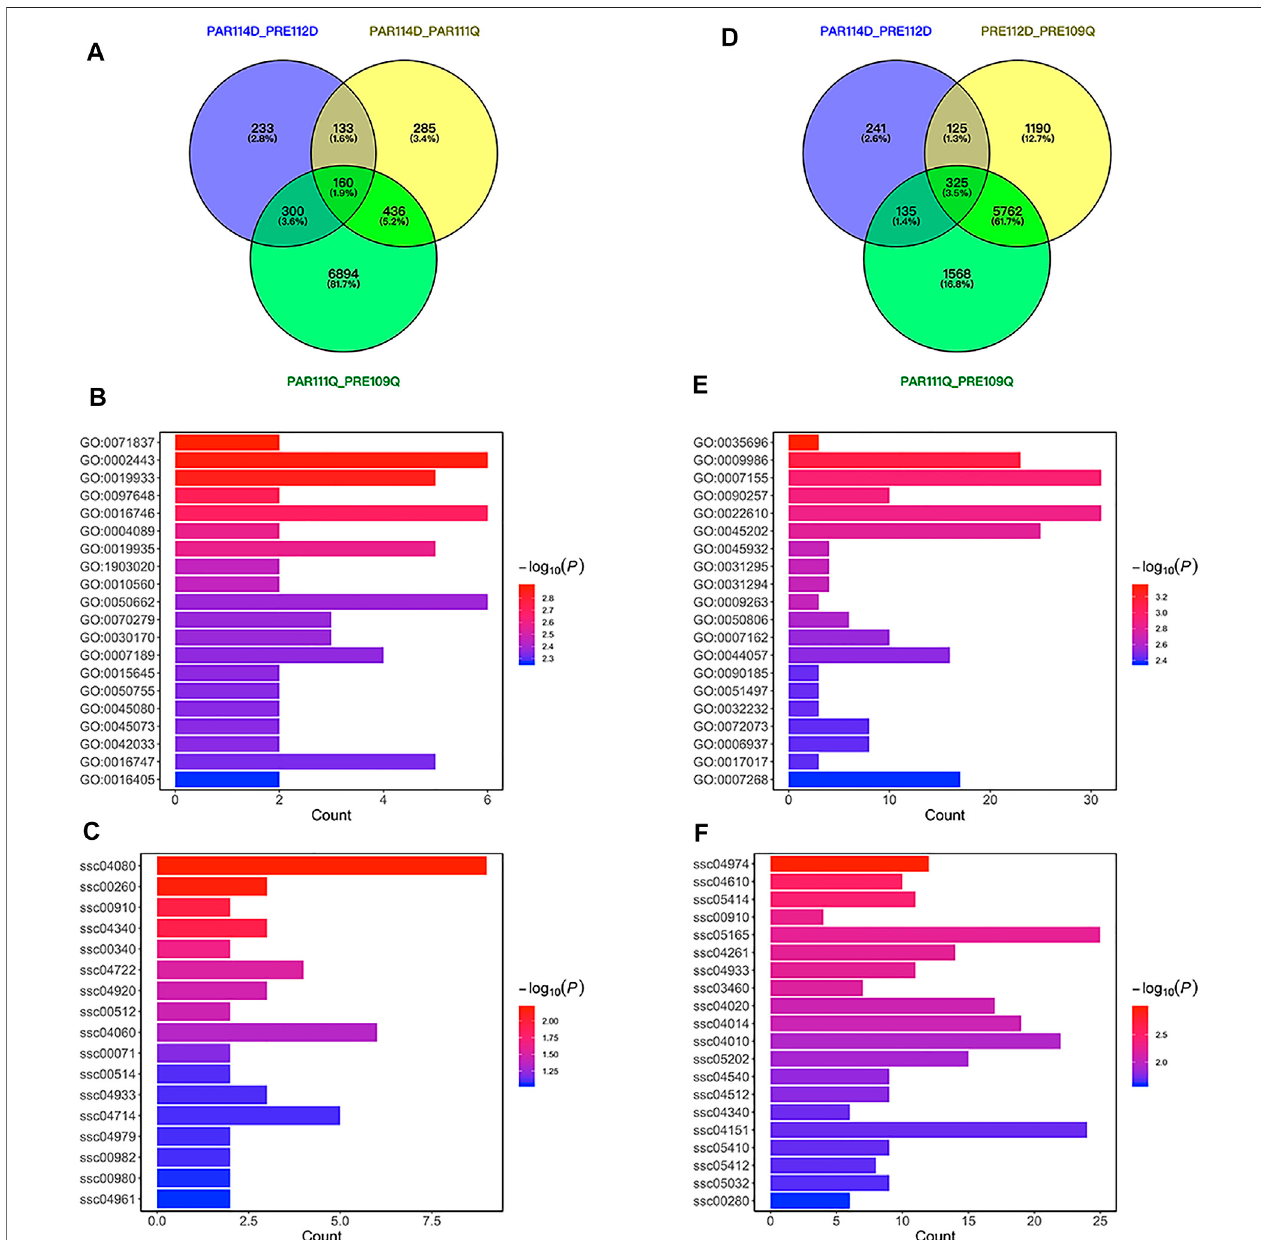
FIGURE3| Differentiallyexpressed genesforshortgestationlength. (A) VENNplotofdifferentiallyexpressedgenesforshort gestationlengthinparturition. (B) Bar plot of GO enrichment for differentially expressed genes in parturition. (C) Bar plot of KEGG pathway enrichment for differentially expressed genes in parturition. (D) VENNplotofdifferentiallyexpressedgenesforshortgestationlengthinlatepregnancy. (E) BarplotofGOenrichmentfordifferentiallyexpressedgenesinlatepregnancy. (F) Bar plot of KEGG pathway enrichment for differentially expressed genes in late pregnancy.